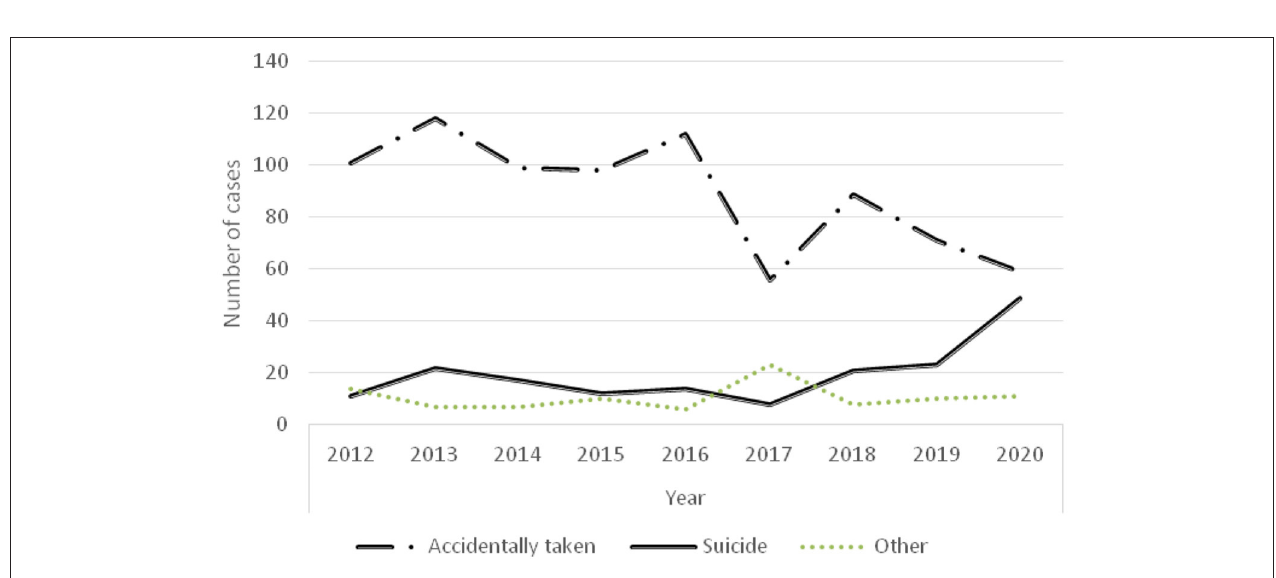
FIGURE 5 | Time-varying curve of paraquat and diquat poisoning.